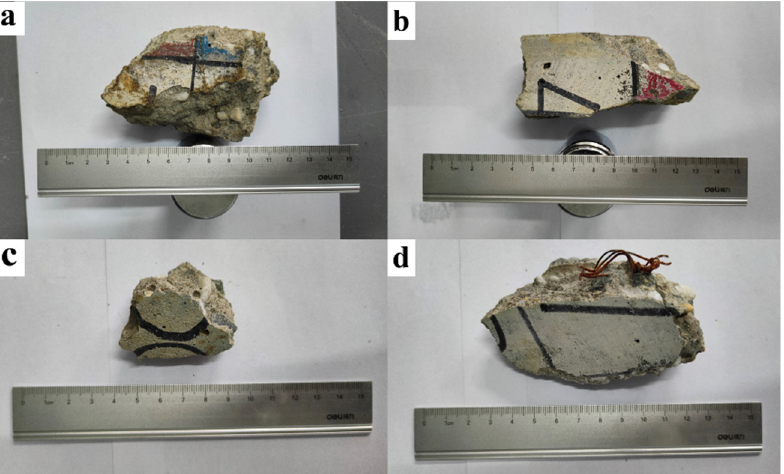
Figure 22. Launch velocity of concrete fragments.